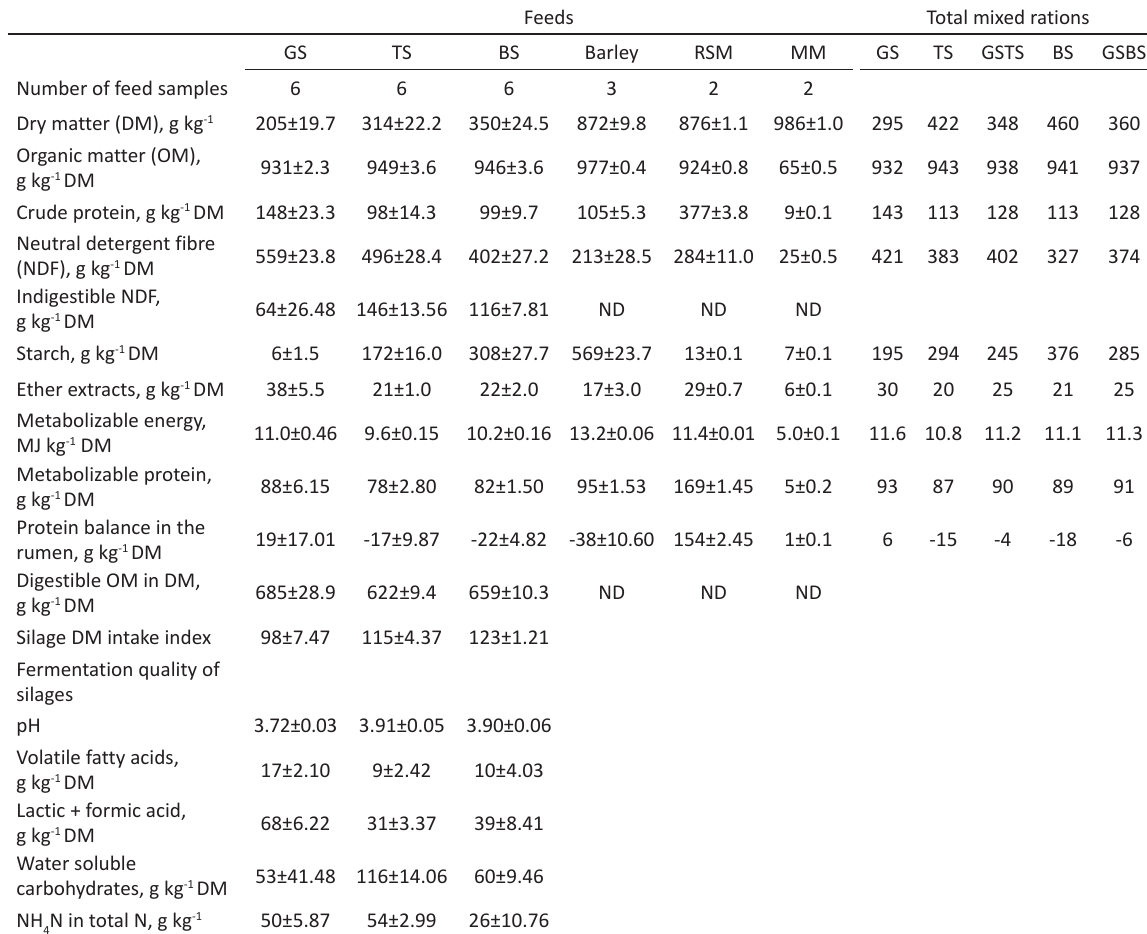
Table 2. Chemical compositions and feeding values (mean ± standard deviation) of the experimental feeds and calculated chemical compositions and feeding values of the total mixed rations used in the feeding